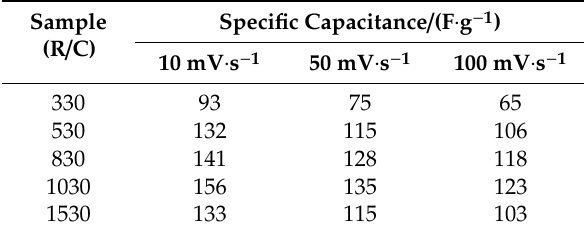
Figure 3. ( a ) The cyclic voltammetry (CV) curves of CA samples with different R/C in 6 mol/L KOH solution at the scan rate of 10 mV/s and ( b ) the EIS Nyquist plots of CAs with different R/C. Table 2. The specific capacitance of different CAs.